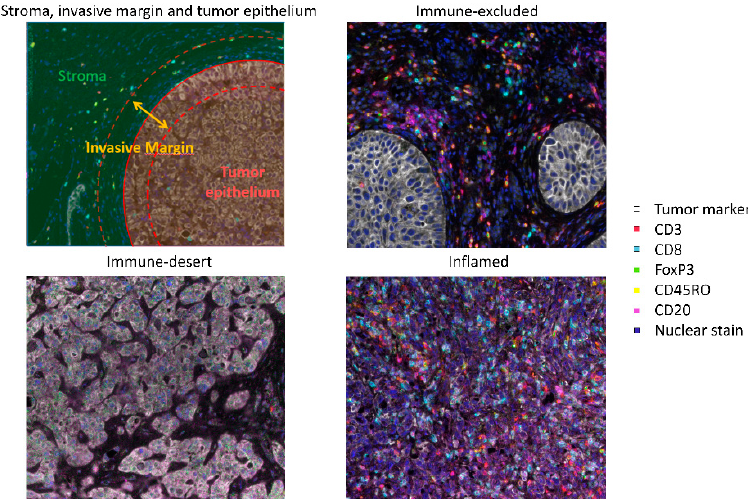
Figure 1. The upper left panel illustrates how tumor tissue can be segmented into the stroma, invasive margin and tumor epithelium. The invasive margin, sometimes also called the peritumoral region, is defined as the border of the tumor nest, including a small stromal and a small intraepithelial region. In the other panel, multiplex immunohistochemistry images of bladder cancer specimens with an immune-desert (lower left), immune-excluded (upper right) and inflamed (lower right) phenotype are shown.